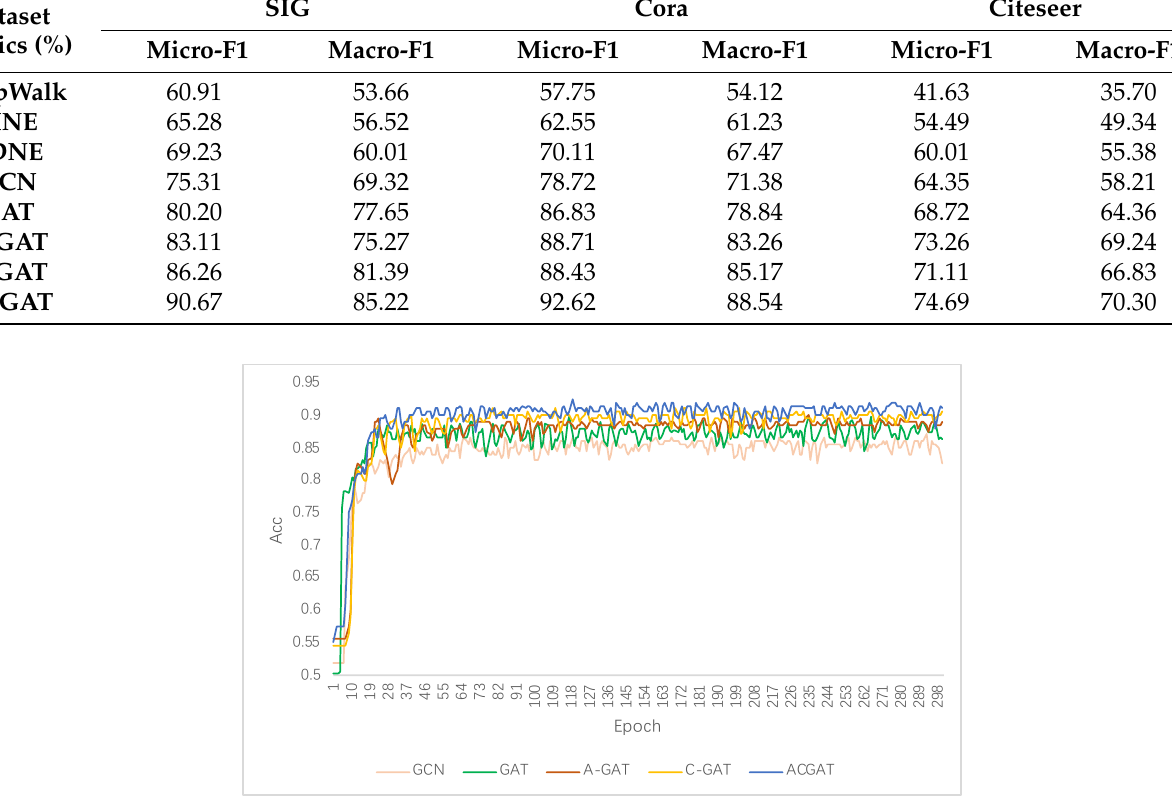
Figure 12. The comparison results of neural network models on the SIG scholar network.